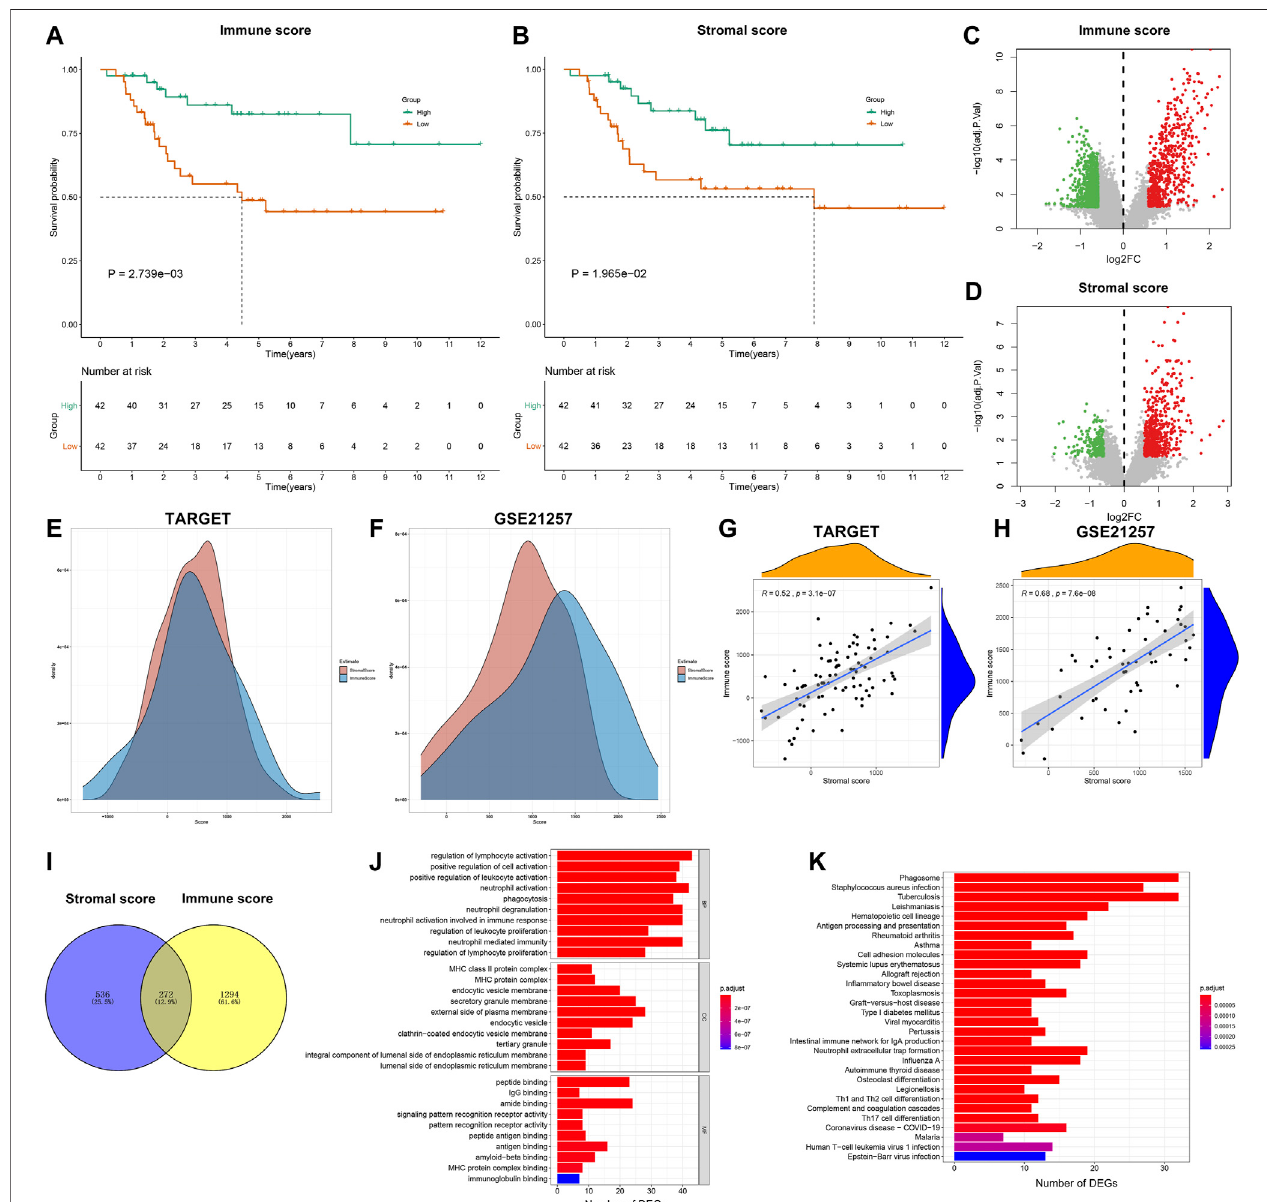
FIGURE 2 | Stromal and immune scores are associated with survival outcomes of osteosarcoma patients. (A,B) Kaplan – Meier curves of overall survival (OS) between high and low (A) immune and (B) stromal score groups in the Therapeutically Applicable Research to Generate Effective Treatments (TARGET) database. The statisticaldifferenceswerecomparedbylog-ranktest.Thedashlinesmeanthecorrespondingsurvivaltimewhensurvivalprobabilitywas0.5. (C,D) Volcanoplotsofup- (red)anddownregulated(green)genesbetweenhighandlow (C) immuneand (D) stromalscoregroupsintheTARGETdatabase. (E,F) Thedistributionsofstromal score and immune score across osteosarcomasamples in the TARGET and GSE21257 datasets. (G,H) Correlations between stromal score and immunescore across osteosarcoma samples in the TARGET and GSE21257 datasets. (I) Venn diagram for stromal – immune score-based differentially expressed genes (DEGs) in osteosarcoma. (J) Geneontology(GO)includingbiologicalprocess(BP),cellularcomponent(CC)andmolecularfunction(MF)and (K) KyotoEncyclopediaofGenesand Genomes (KEGG) enrichment analysis results of stromal-immune score-based DEGs.